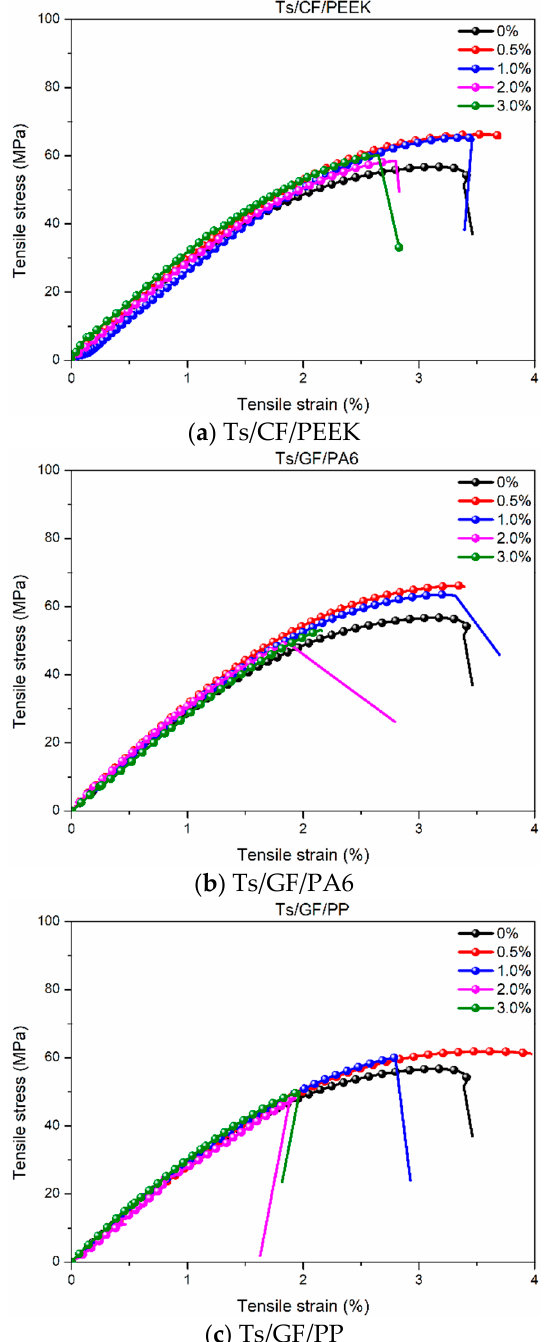
Figure 5. Effects of thermoplastic composite fillers on the tensile stress-strain curves of Ts resin of ( a ) Ts/CF/PEEK, ( b ) Ts/GF/PA6 and ( c ) Ts/GF/PP.